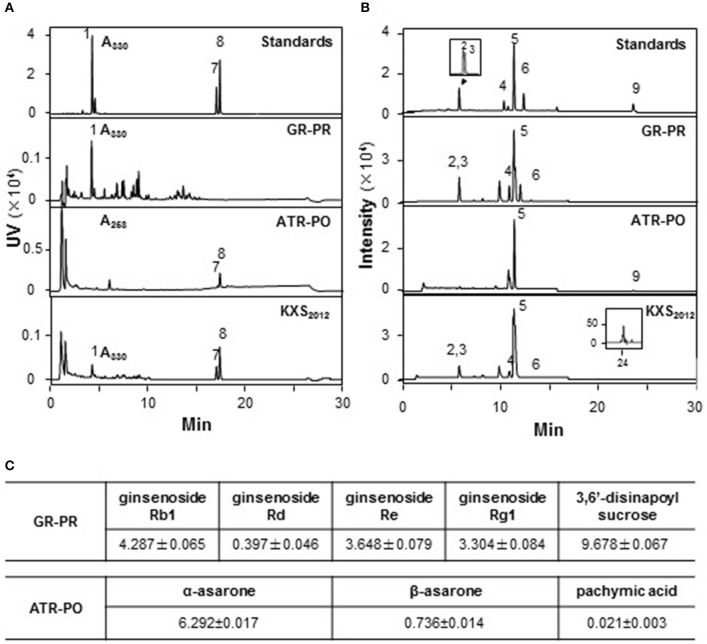
Standardization of herbal extracts. (A) The standardization of herbal extracts was described in our previous report (Zhu et al., 2010). The identification of 3, 6′-disnapoyl sucrose (330 nm) (1), α-asarone (258 nm) (8), and β-asarone (258 nm) (7) was made by a HPLC coupled with a DAD detector in paired-herb extracts. This HPLC profile served as fingerprint and determination of marker chemicals. (B) In chemical assessment, the identification of ginsenoside Rg1 (2), Re (3), Rb1 (4), Rd (6), astragaloside IV (5) and pachymic acid (9) was made by a MS detector in standard markers and paired-herb extracts. The amounts of each chemical in mg/g of dried herbal extract were shown in (C), Mean ± SEM, n = 3.